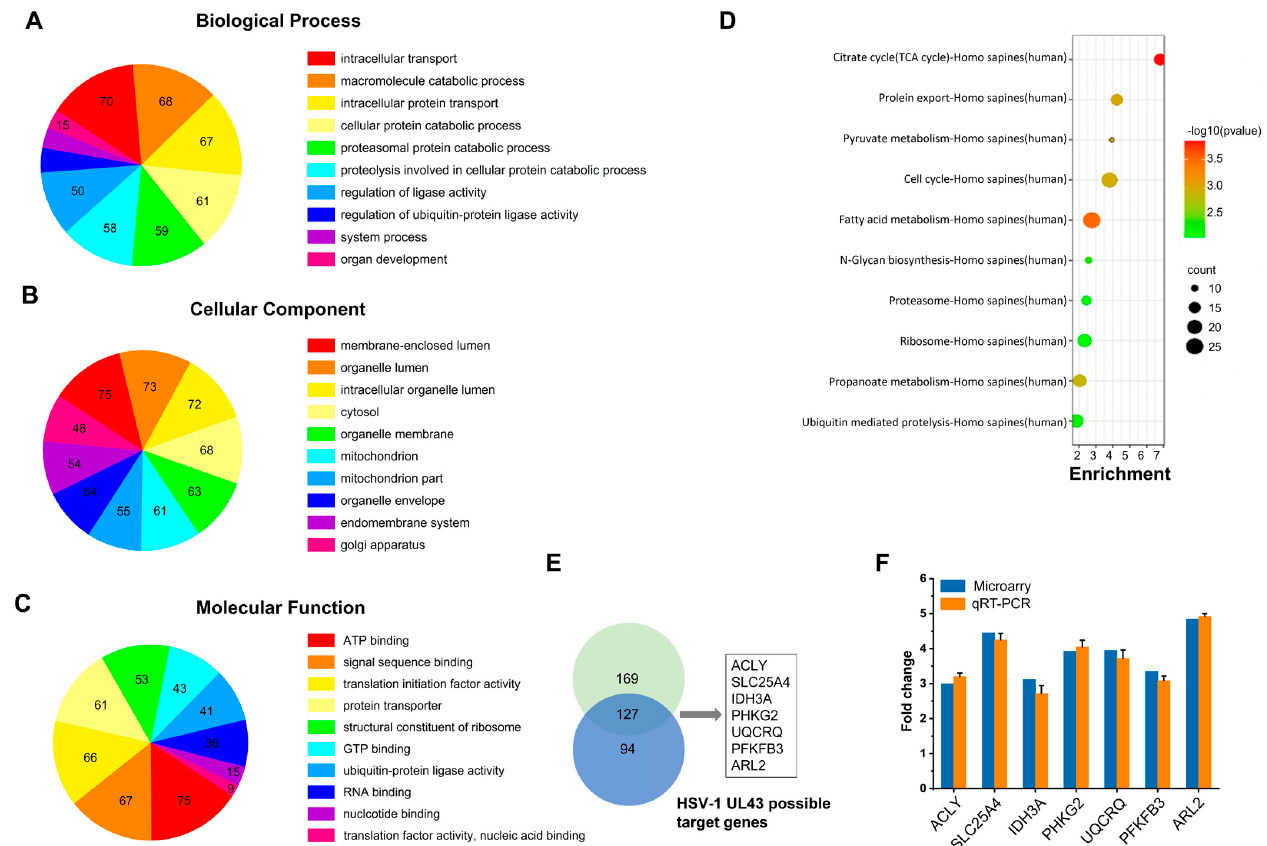
Figure 2. Microarray data analysis and validation of array data by quantitative real-time PCR. GO enrichment analysis of DEG: ( A ) biological process, ( B ) cellular component, ( C ) molecular function. ( D ) KEGG Pathway analysis of DEG showing the top ten enrichment scores of pathways. ( E ) Venn diagram of the significantly regulated DEG in multiples over two folds changes. ( F ) DEG were validated by qRT-PCR for microarray fold changes. Fold changes were determined by calculating the ratio of the mean expression values from the control and samples.